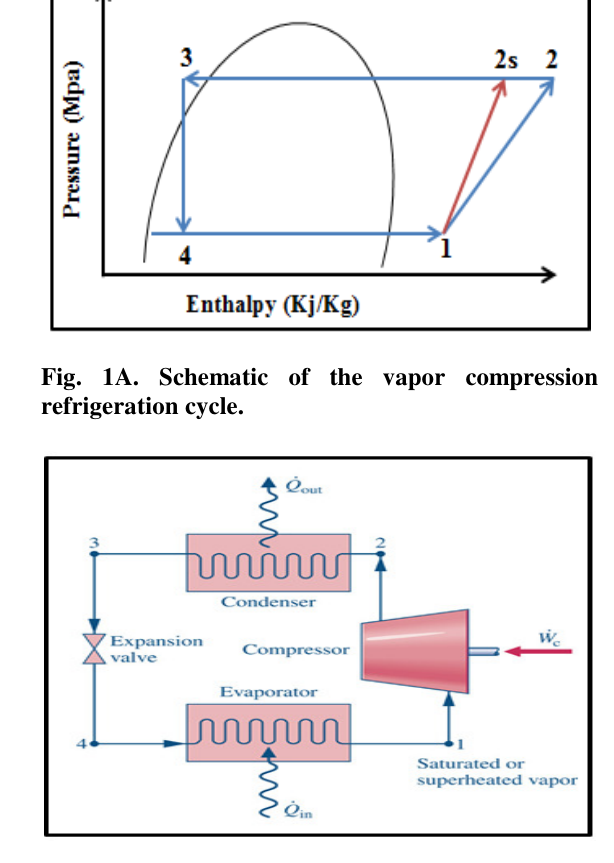
Fig. 1 B. Refrigeration air conditioning